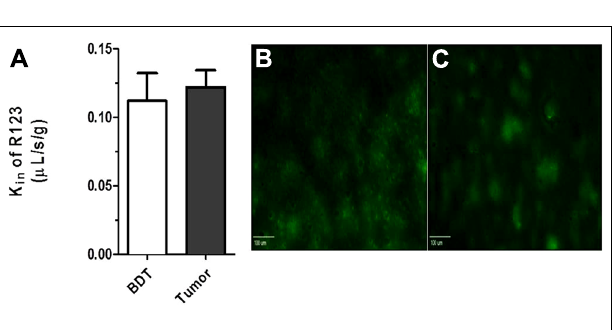
FIGURE 4 | (A) No difference ( p > 0. 05; student t -test, n = 3–5) was seen between R123 blood to brain transfer constant K in between values measured in normal brain ( K in = 0.11 + 0.01 μ L/s/g) and metastases ( K in = 0.12 ± 0.02 μ L/s/g). Representative R123 fluorescence images in normal brain (B) and within a metastasis (C) (scale bar = 100 μ